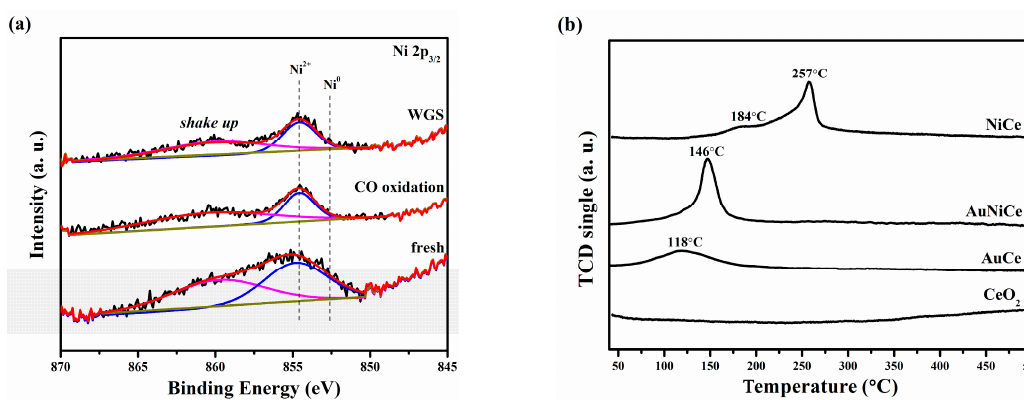
Figure 8. ( a ) XPS spectra of Ni 2p for AuNiCe ; ( b ) H 2 -TPR profiles for fresh AuNi/CeO 2 samples.